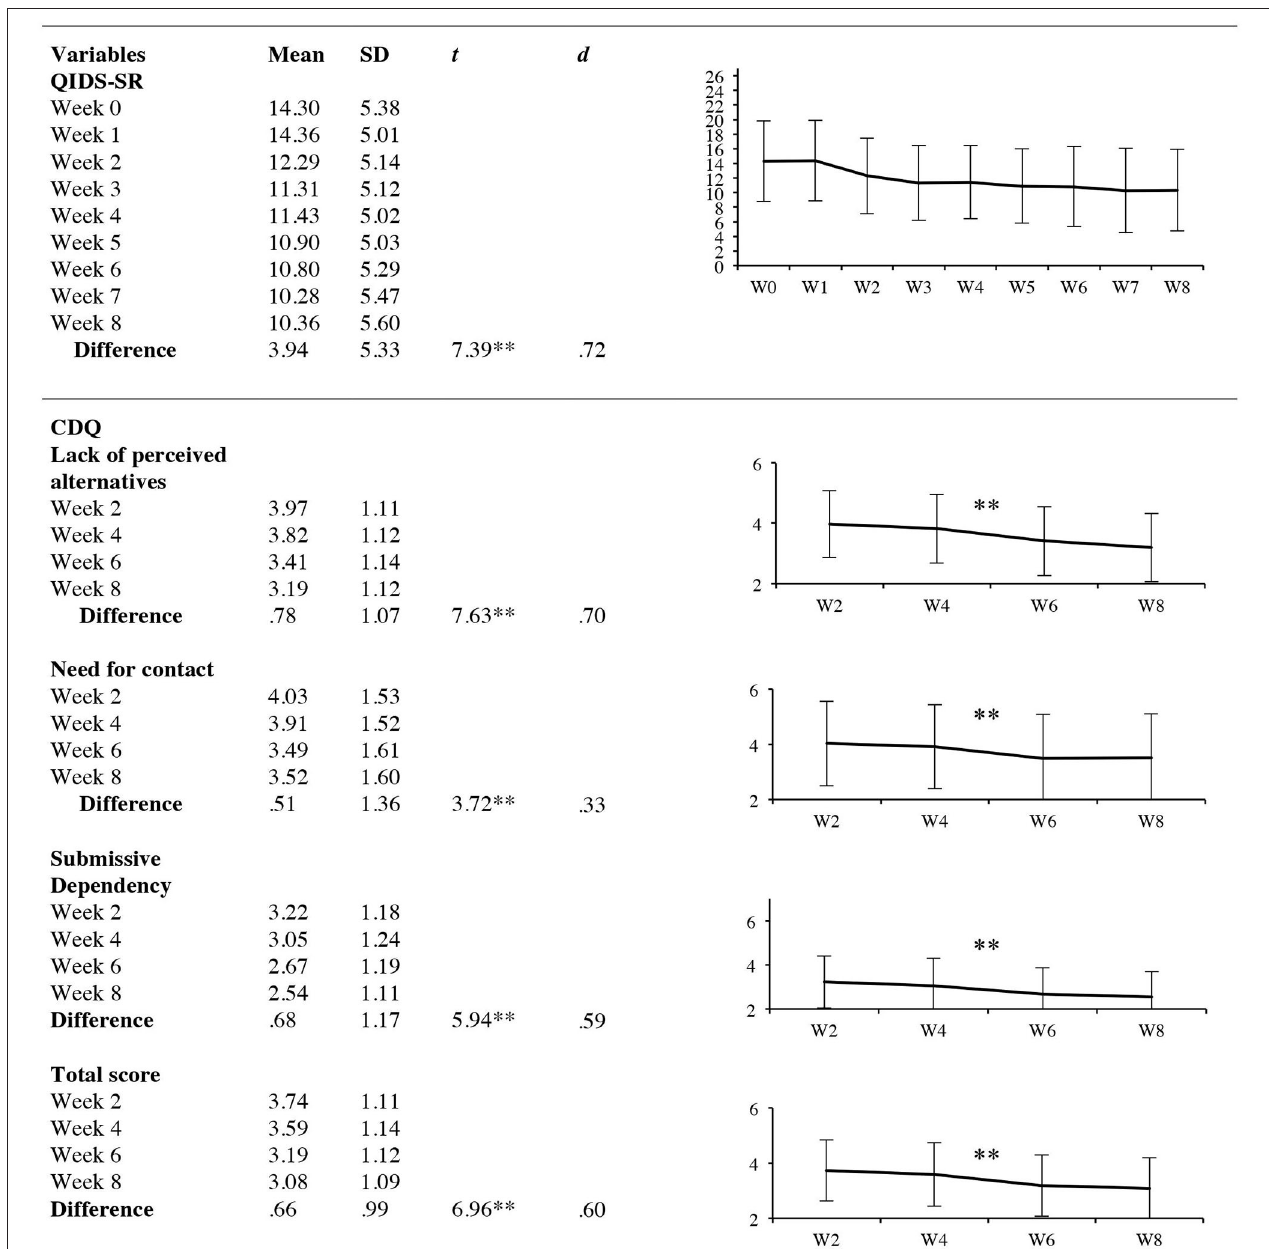
FIGURE 2 | Results of secondary analyses. Development of depressive symptoms and care dependency. QIDS-SR, quick inventory of depressive symptomatology, short form; CDQ, care dependency questionnaire, effect sizes d were calculated for pre-post differences. * p < 0.05, ** p < 0.001.